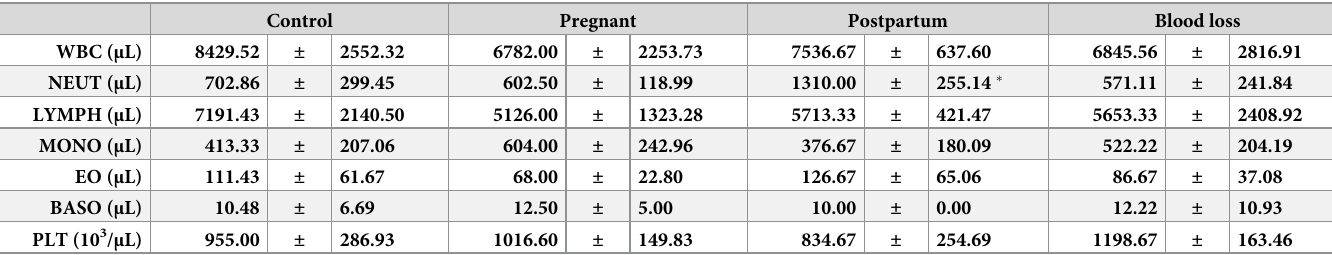
Table 1. Analyses of white blood cells (WBCs) and platelets (PLTs) in uninfected pregnant and postpartum mice. Control Pregnant Postpartum